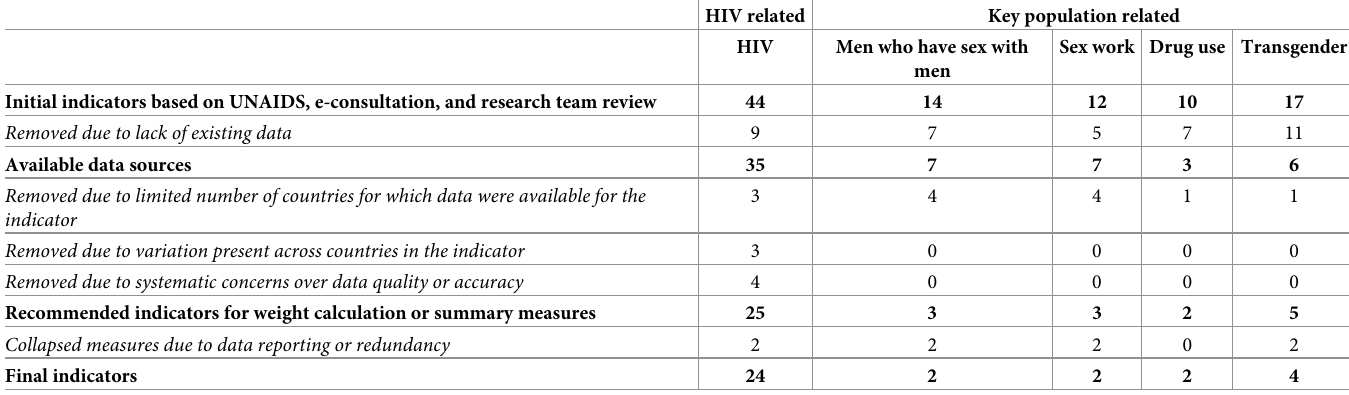
Table 1. Summary of stigma indicator mapping identification, extraction, selection, and